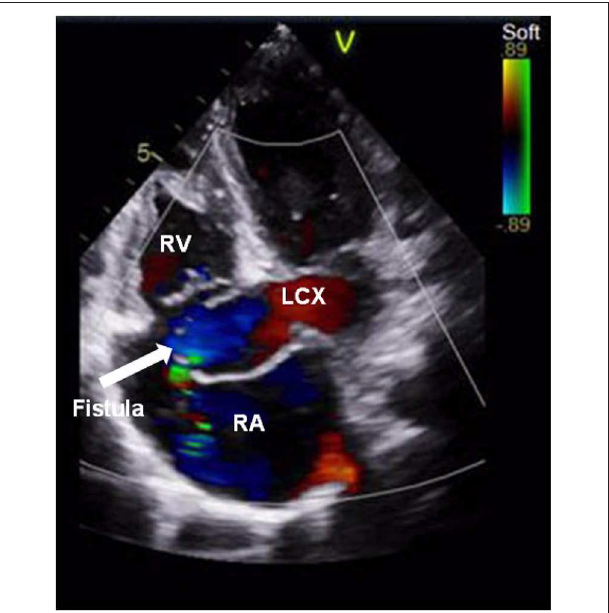
FIGURE 2 | Color Doppler examination showed a coronary artery fistula from the left circumflex artery to the right atrium. The arrow points to the fistula. RV, right ventricle; LCX, left circumflex artery; RA, right